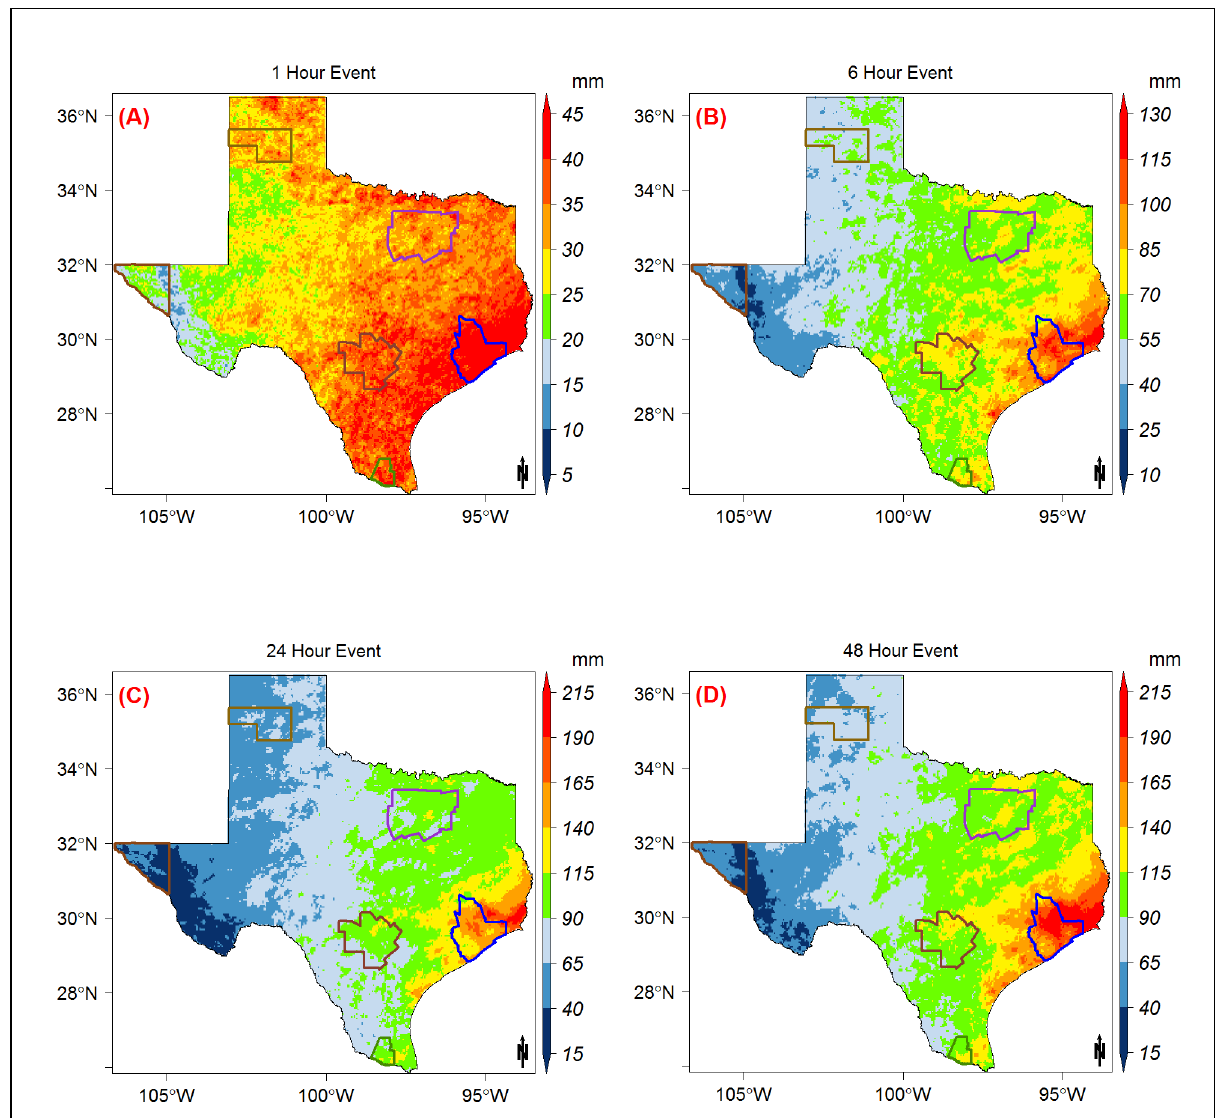
Figure 3. Spatial distribution of the average of the annual maxima series for or the ( A ) 1-h, ( B ) 6-h, ( C ) 24-h, and ( D ) 48-h duration storms.